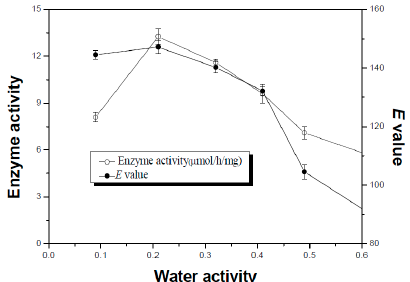
Figure 5. Effect of water activity on the enzymatic esterification of ibuprofen. Reaction conditions: the reactions were carried out in n -heptane (10 mL) with racemic ibuprofen (0.2 mmol), 1-octanol (0.2 mmol) and the immobilized APE1547 powder (160 mg) at 45 °C. The ultrasound power was 225 W.